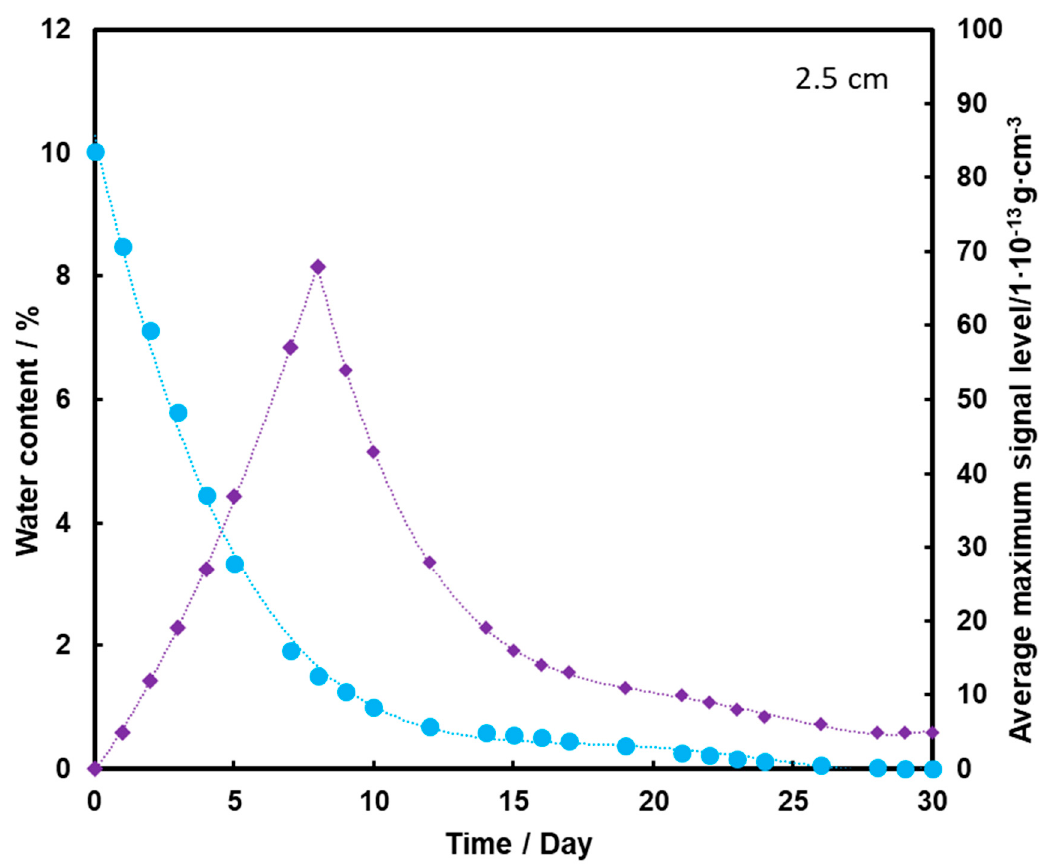
Figure 6. Dependence of the mean maximum TNT signal ( ♦ ) on the amount of water ( ● ) in the substrate for the TNT sample at a depth of 2.5 cm, at a temperature of 25 °C.